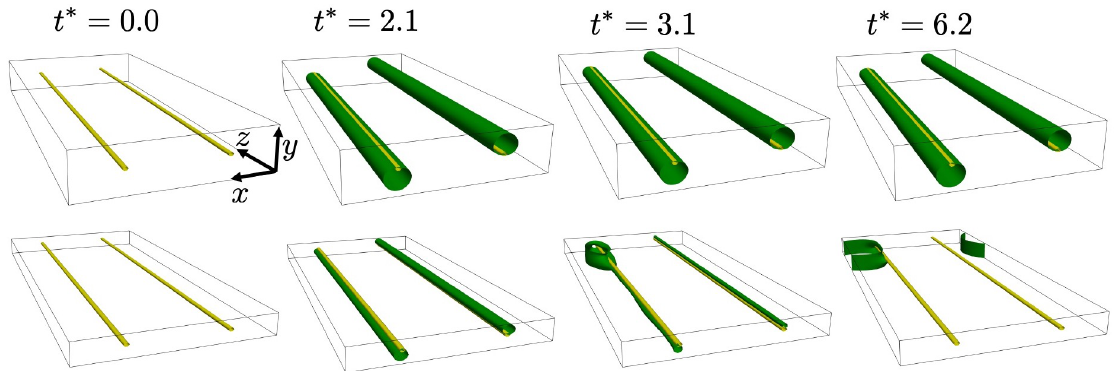
Figure 3. Snapshots of solute segregation to a perfect Peierls-Nabarro edge dislocation dipole for larger ( L x , L y , L z ) = ( 80,20,160 ) a ( L x , L y , L z ) = ( 80,10,160 ) a 0 (above) and smaller 0 (below) simulation cells. The cell orientation is as given in (32). Dislocation lines are shown in yellow, and the 40% solute concentration isosurface in green, and t 0 = 10 2 t c . Note that segregated solute is below (above) the left (right) monopole, corresponding to the region of positive hydrostatic stress. See text for